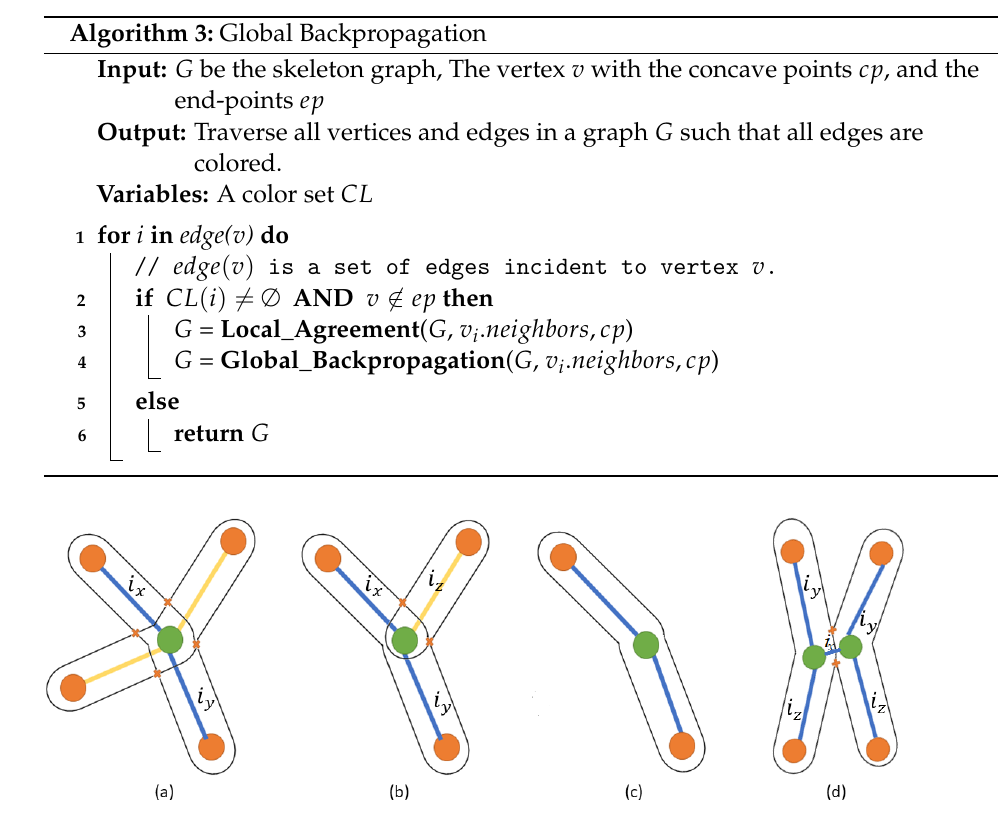
Figure 6. The examples of graph representations of different skeleton connection types. The edges represent the skeleton connections, similar edge colors represent single bacteria cell, the green vertices represent branching points (denoted as bp ) of the skeleton, the orange points represent the endpoints (denoted as ep ), and the cross points represent the extracted concave points (denoted as cp ). Here, ( a – d ) represents an instance of X -type, Y -type, I -type, and H -type,